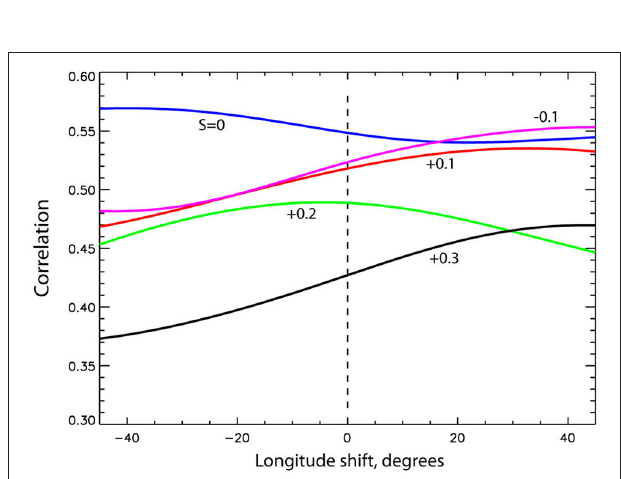
FIGURE 8 | Modified ratios F * C of reversed to normal flux contributions to the axial dipole vs. dimensionless r.m.s. upwelling W * below the core-mantle boundary from numerical dynamos (symbols), compared to the geomagnetic field models on the core-mantle boundary described in the text.